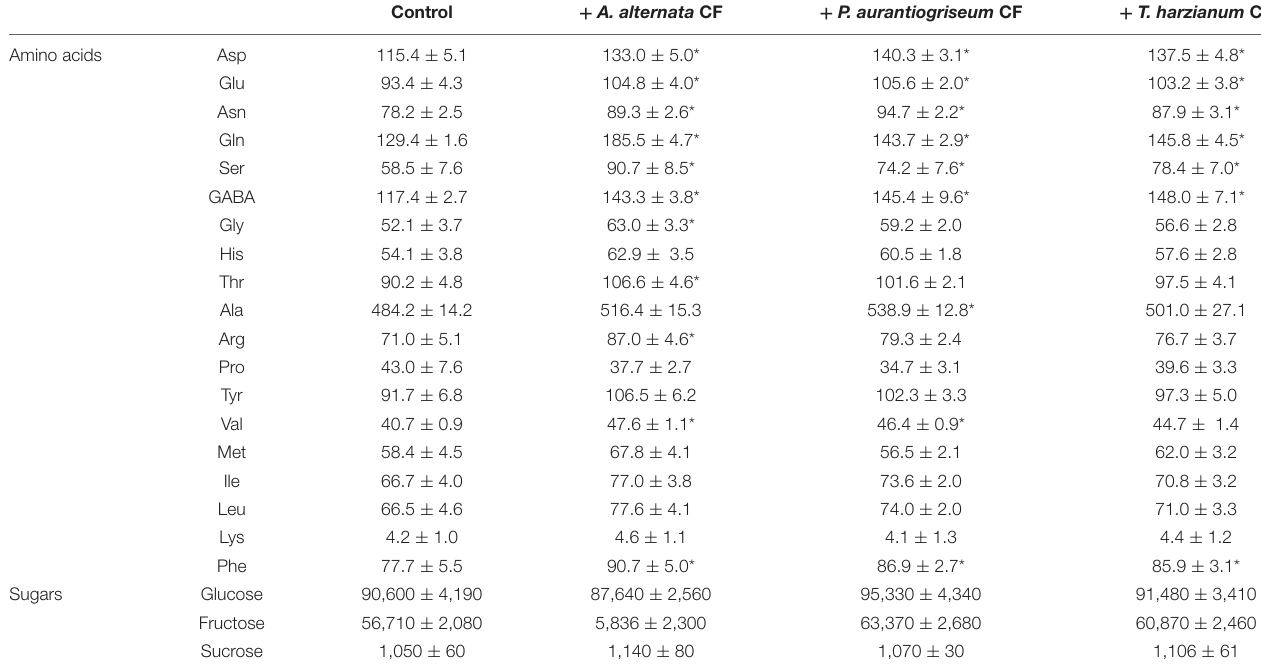
TABLE 2 | Free amino acids and sugar contents (expressed as nmol g − 1 DW) in commercial fruits of pepper plants (cv. Sweet Italian) cultured under greenhouse conditions with or without drench application of fungal CFs.